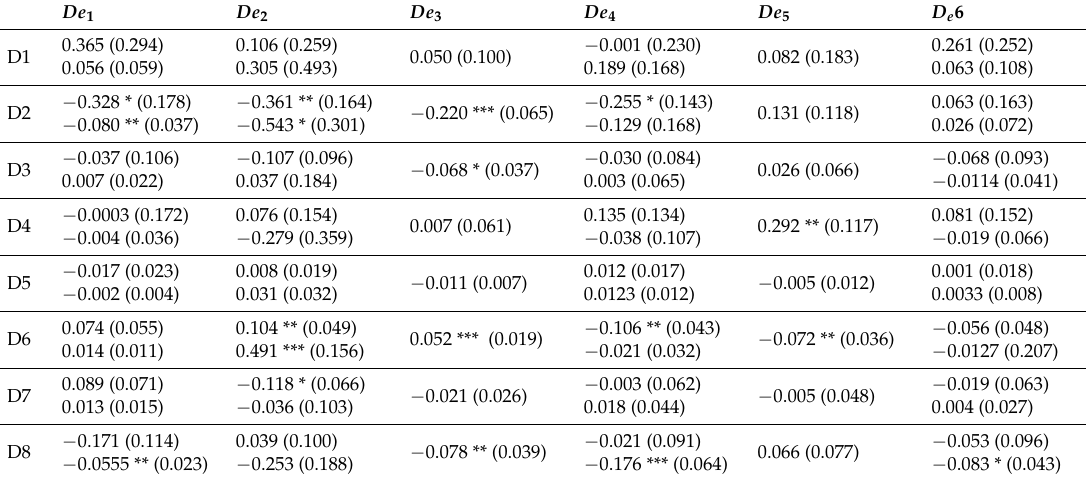
Table A1. Estimation results of the ordered logit and tobit models (part